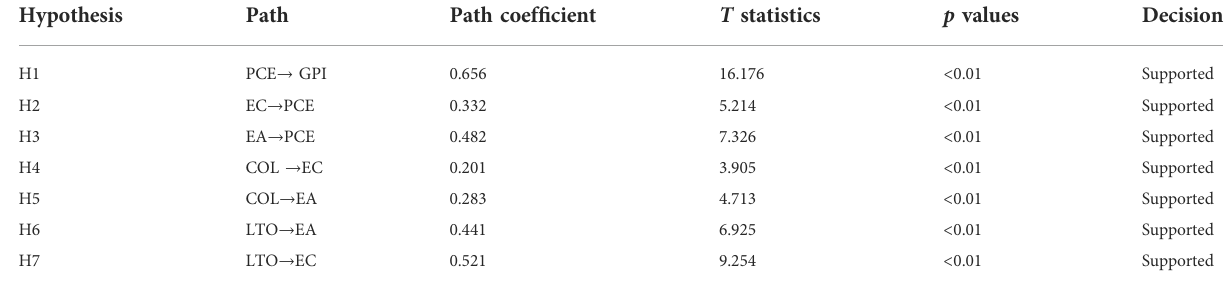
TABLE 6 Structural relationships and hypothesis testing.